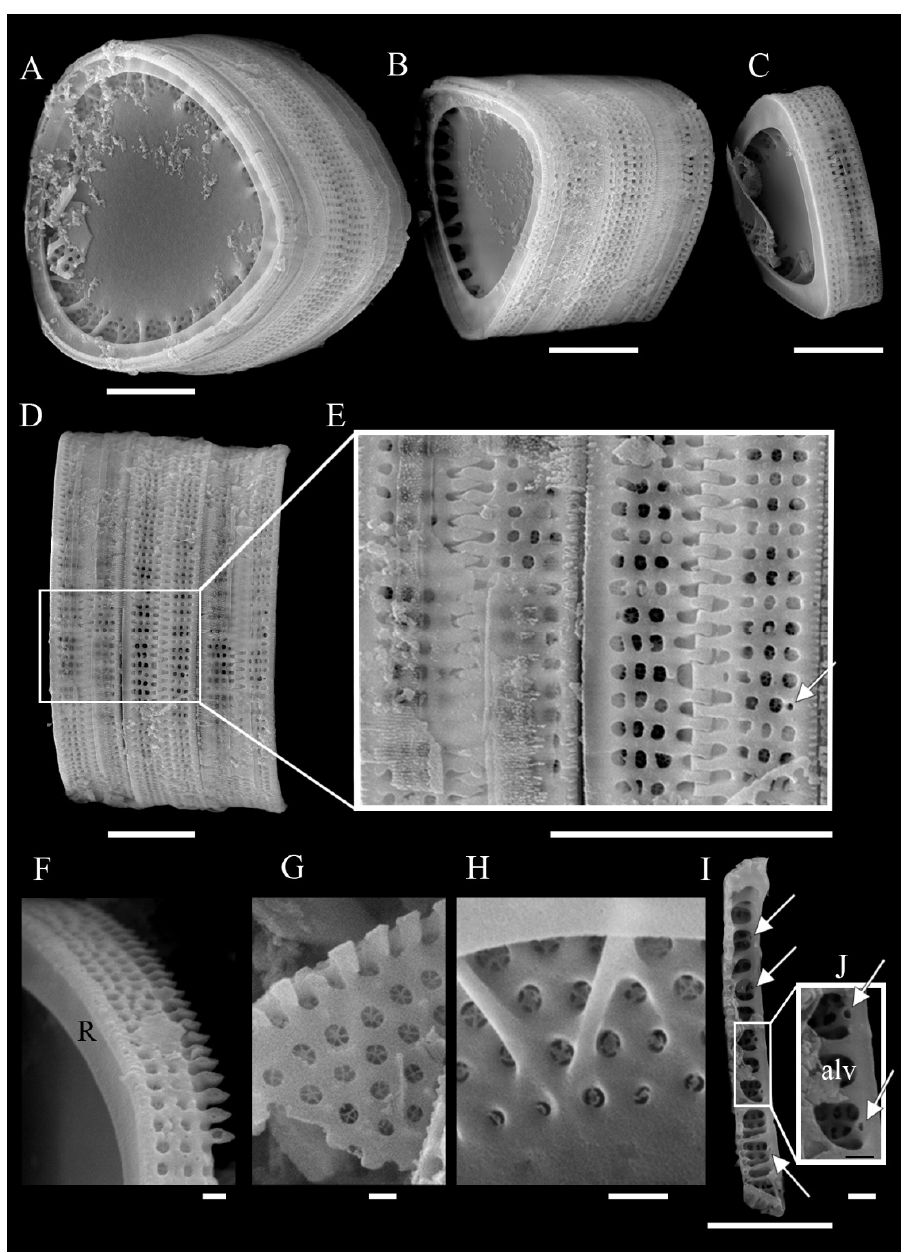
Figure 10. Alveolophora antiqua in the depth interval of 54–53 m from core 517 of the Barguzin Valley: ( A – D )—external views, showing variability of valves; ( E )—fragment of valve D, showing areolae, separating and linking spines, external opening of rimoportulae; ( F )—separating spines; ( G )–areolae on the valve face; ( H )—internal views showing, areolae and costae; ( I , J )—internal view, showing alveolae and rimoportulae (arrows). SEM. Scale bar: 10 µm ( A – E , I ) and 1 µm ( F – H , J ).